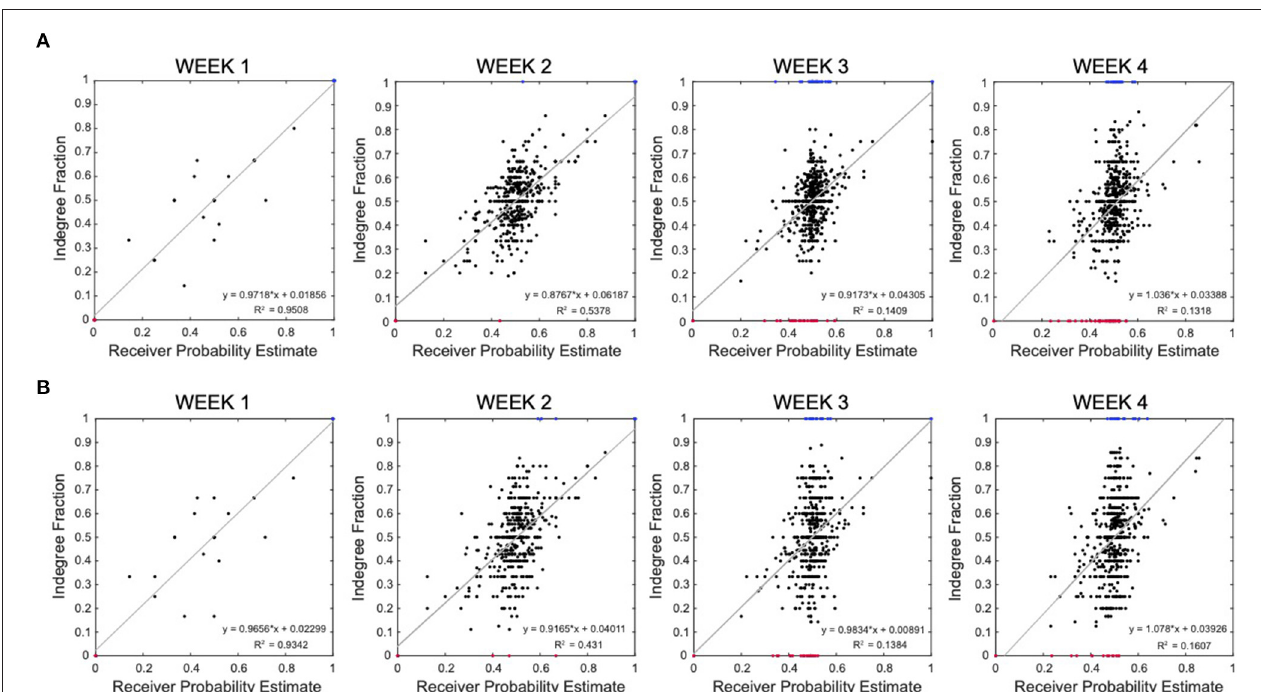
FIGURE 6 | Correlation between inferred network degree and signaling probability estimate in multi-electrode array (MEA) data. (A) Correlation between the receiver probability estimate (x-axis) and the in-degree fraction (y-axis). Each data point in the plots represent an active neuron in a reconstructed well connectivity with computed estimate of probability of being a receiver node and in-degree fraction. The plots combine all the results from 20 wells, recorded at week 1, 2, 3, and 4, respectively. Neurons with in-degree fraction 1 (sink) and 0 (source) have been highlighted in blue and red, respectively. The gray curve is the linear regression. (B) Correlation between the receiver probability estimate (x-axis) and the in-degree fraction when the connectivity is inferred via correlation peak selection based on the Pearson correlation (y-axis).